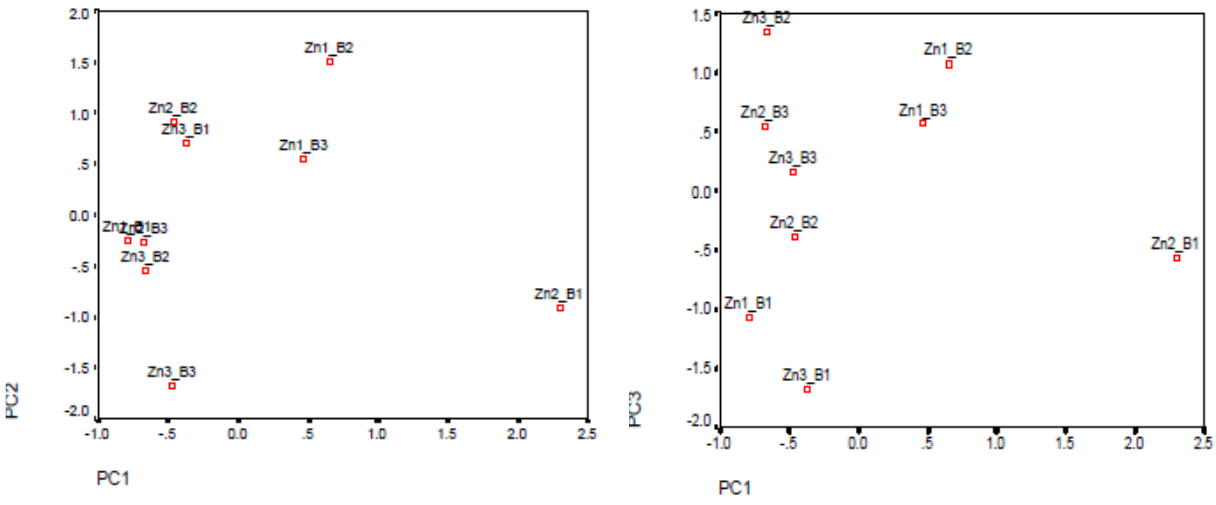
Fig. 1. Scatter diagram of the regression factor scores for the first and second components produced by PCA